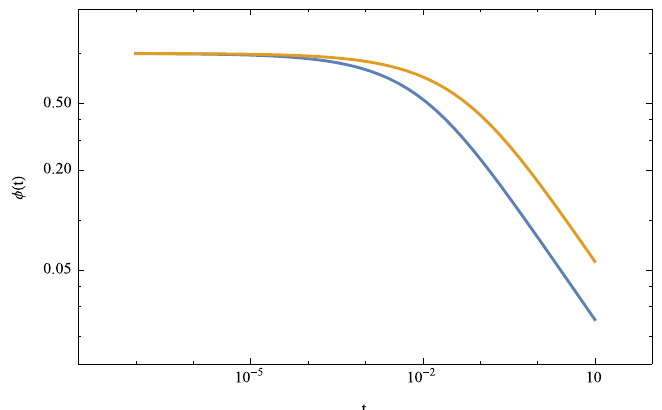
Figure 6. Non-linear fractional relaxation equation (89) (upper line). The initial condition and the relaxation time (cid:28) , and the fractional order (cid:12) was set to ϕ 0 25 = 20 , and (cid:12) = 1 = 2 . The lower curve represents the solution of the relaxation equation (84) using the same parameters. The Sinc approximation of the Caputo representation used N = 64 Sinc